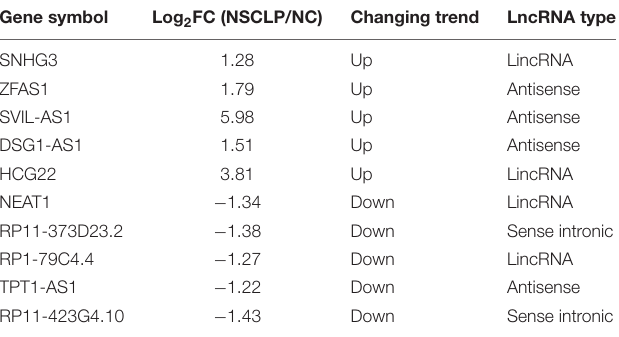
TABLE 1 | Basic information of 10 lncRNAs selected from lncRNA